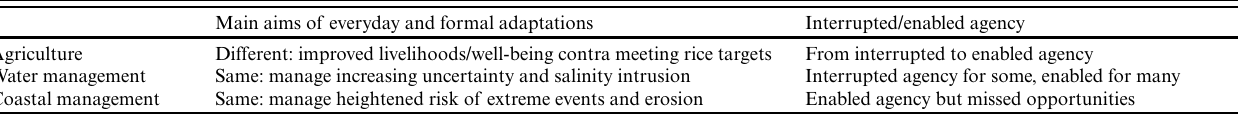
Table 2. Overview of adaptation